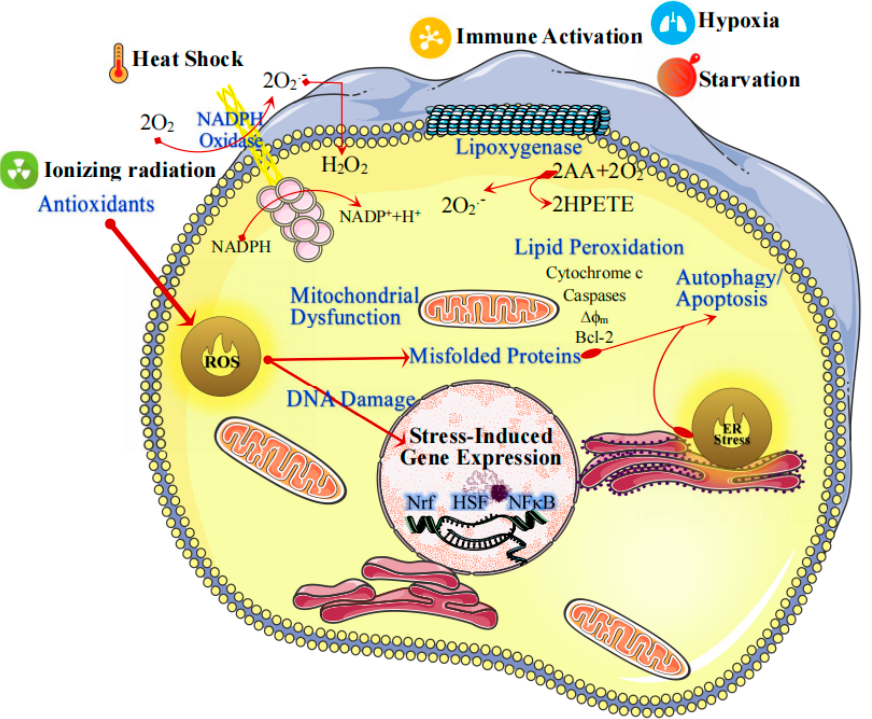
Figure 1. The determinants and consequences of oxidative stress. Oxidative stress causes an imbalance in free-radical formation through multiple pathways which can trigger programmed cell death pathways, and it has been linked to clinically relevant diseases [22–24].